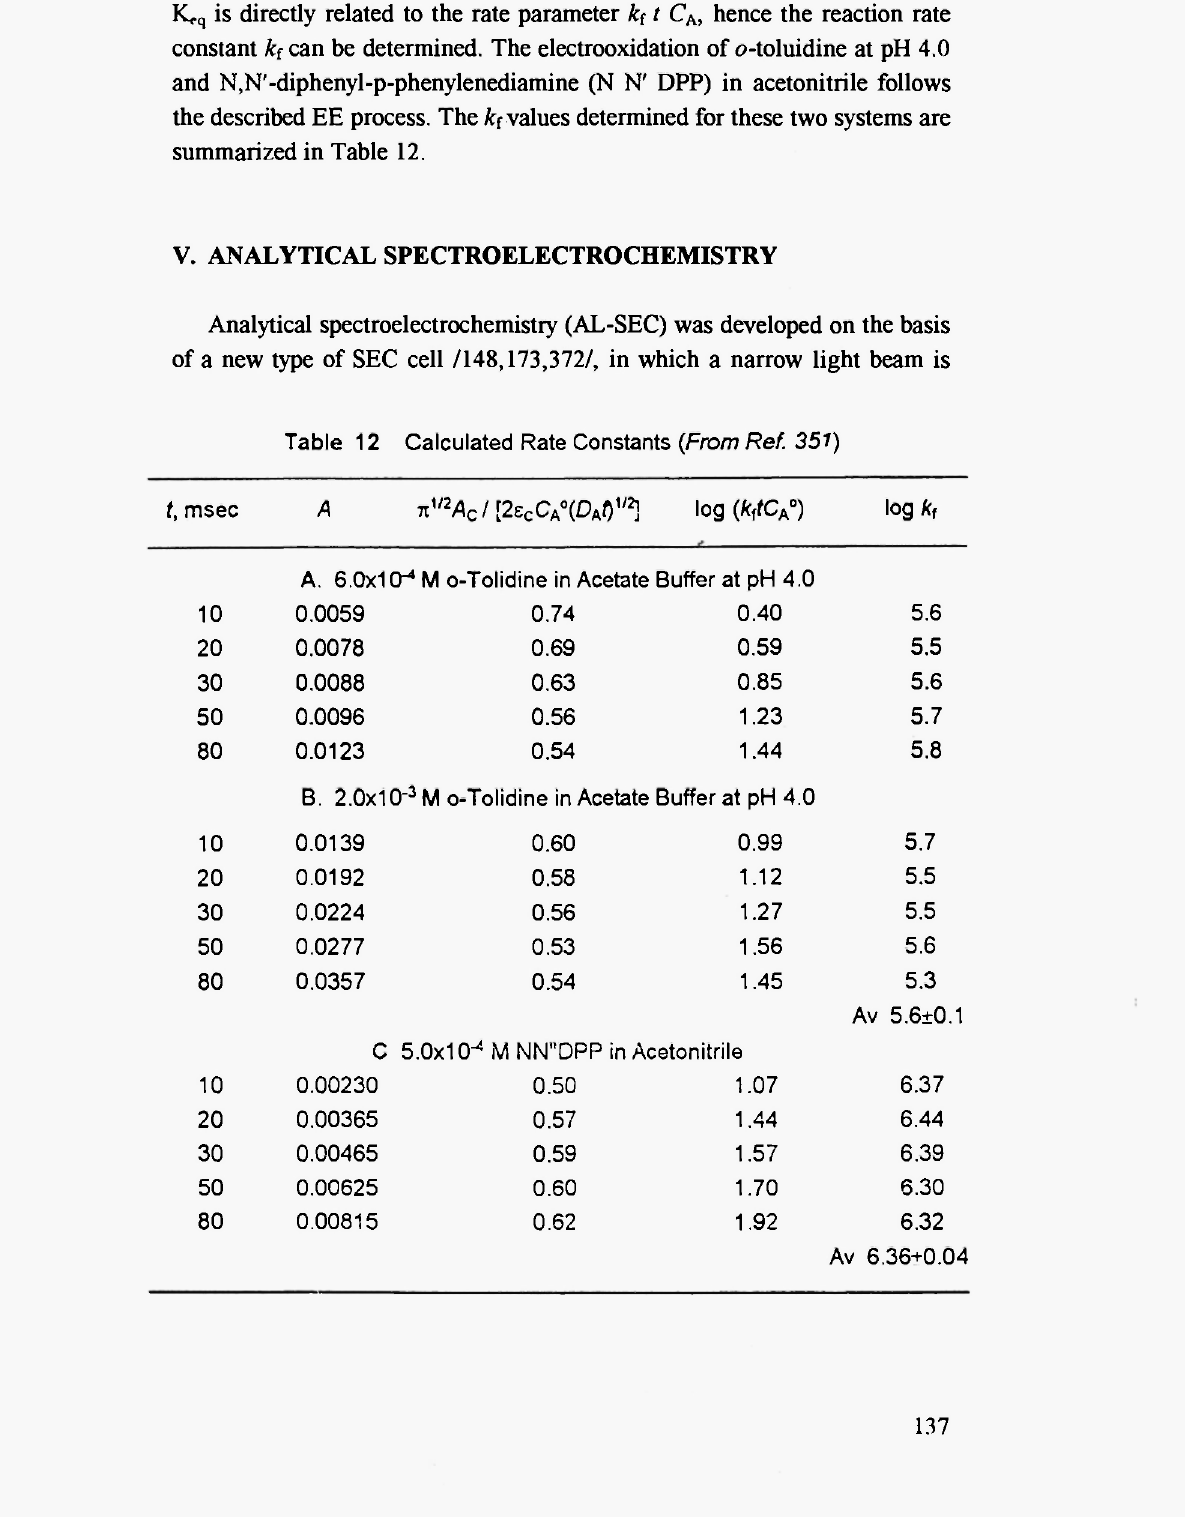
Calculated Rate Constants {From Ref.